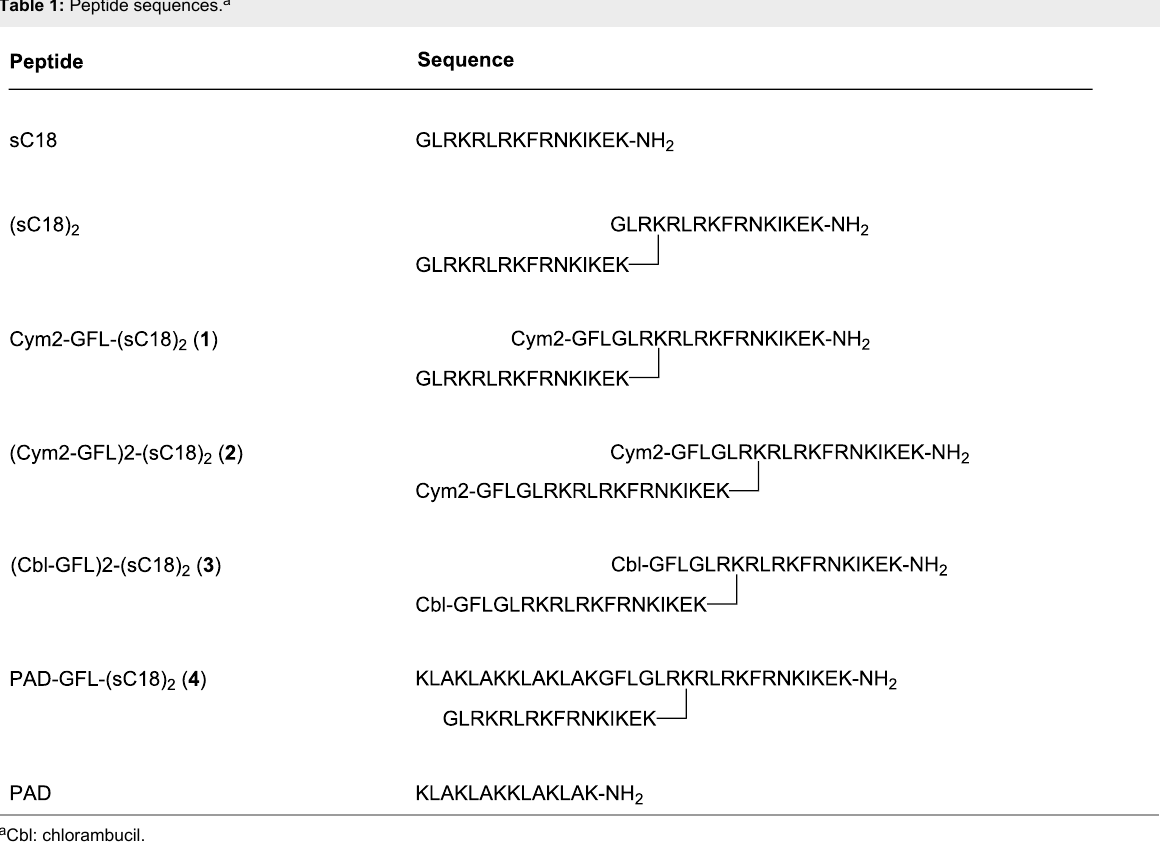
Table 1: Peptide sequences. a